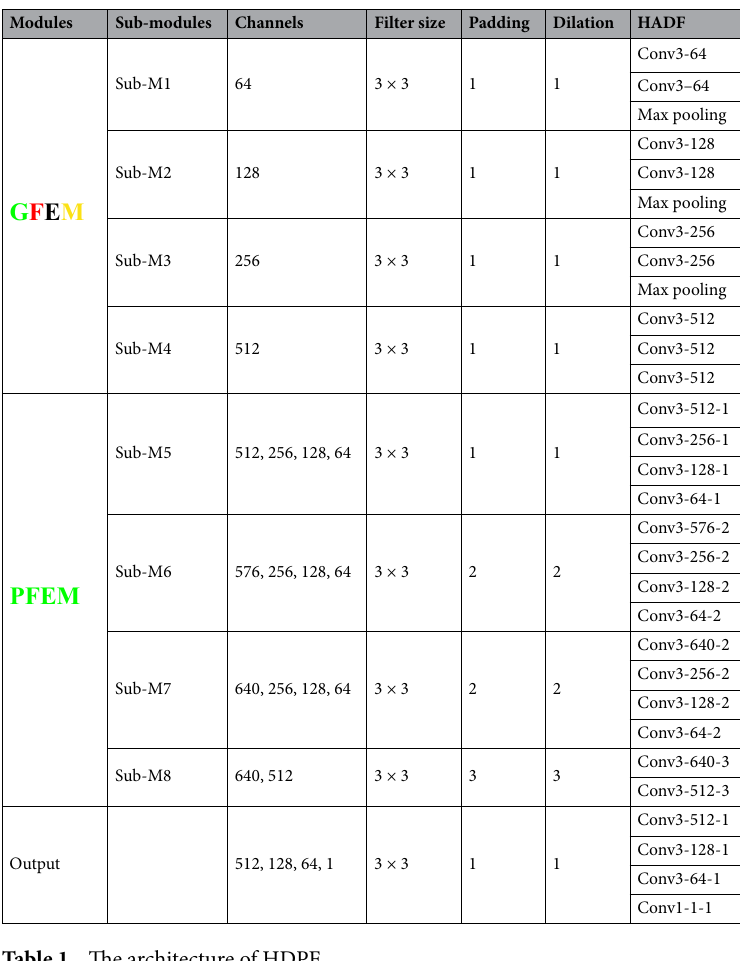
Table 1. The architecture of